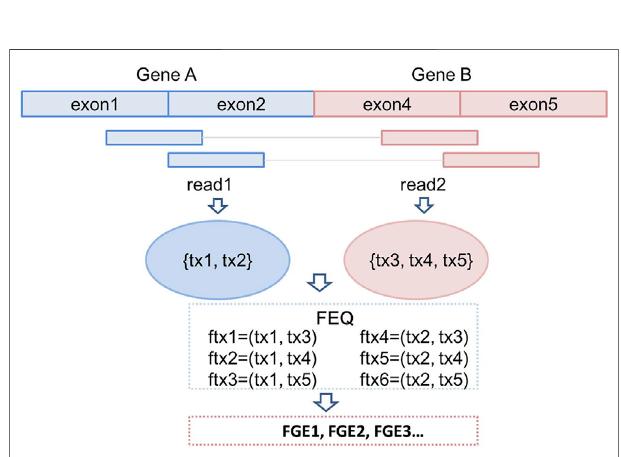
FIGURE 2 | Construction of fusion equivalence class and fusion transcripts; prediction of fusion